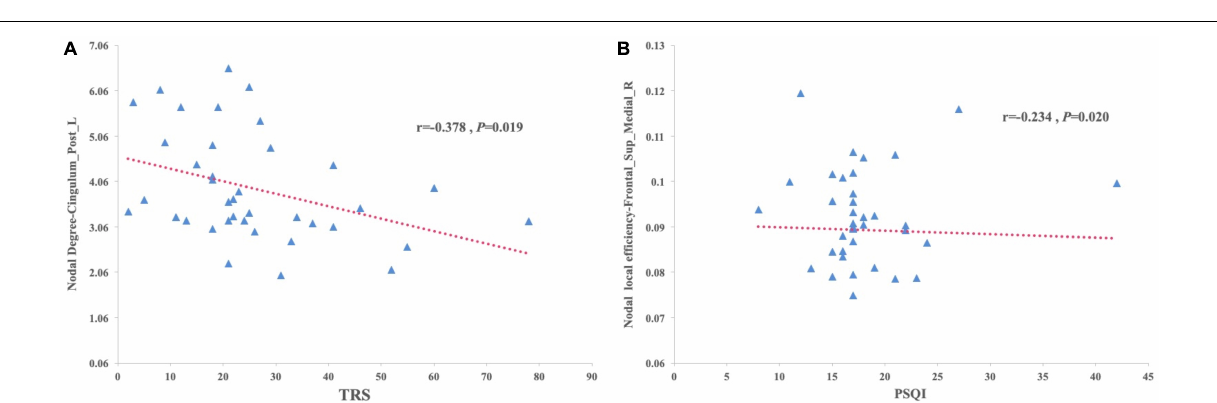
FIGURE 3 | Scatterplots of correlation between the brain regions that show decreased nodal degree or decreased nodal efficiency trend with clinical characteristics in patients with SleET. (A) The TRS scores of SleET was negatively correlated with the nodal degree of Left posterior cingulum gyrus. (B) The PSQI scores of SleET was negatively correlated with the nodal efficiency of right medial superior frontal